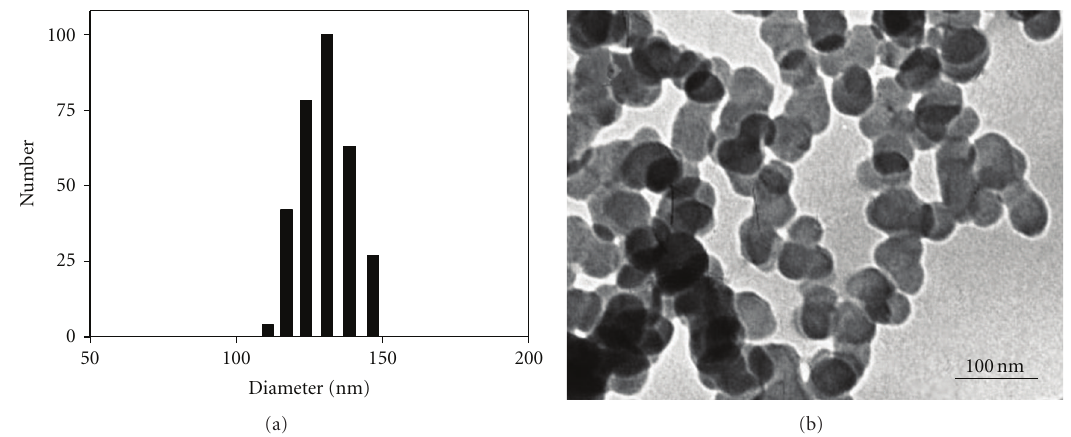
Figure 2: (a) Hydrodynamic diameter distribution and (b) TEM image of the nanomicelles.